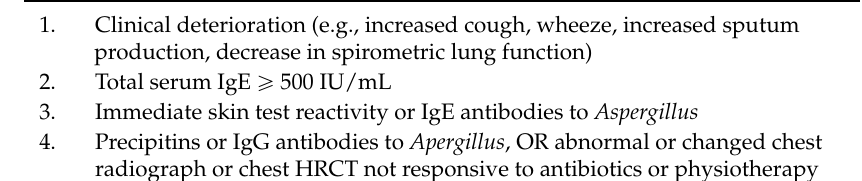
Table 3. Consensus Conference 2003 minimal diagnostic criteria for diagnosis of ABPA in cystic fibrosis